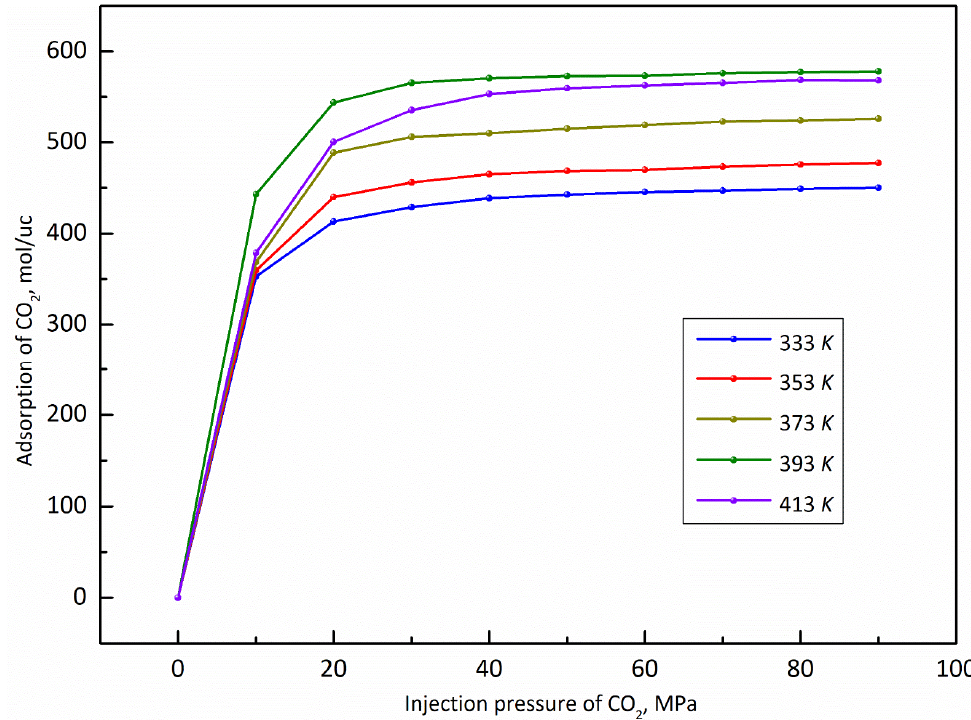
Figure 10. The molar quantity of CO 2 absorbed in the pores under different temperature at different injection pressure of CO 2.